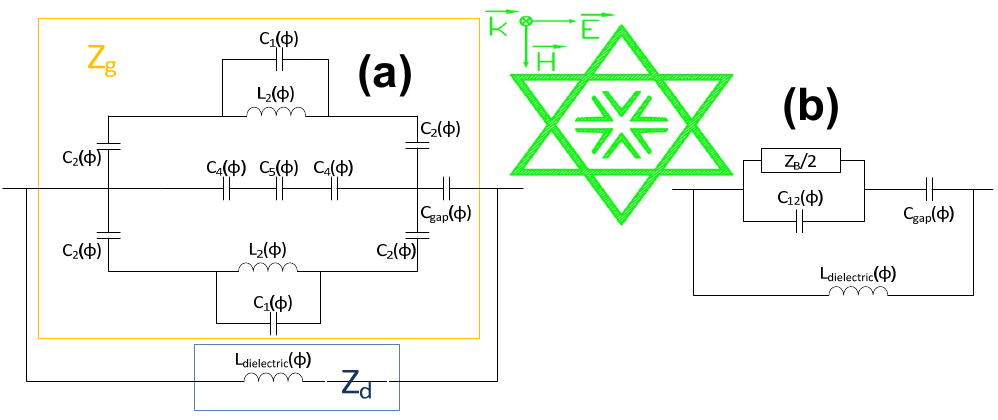
Figure 14. ( a ) Equivalent circuit for TE polarization and ( b ) its simplification.